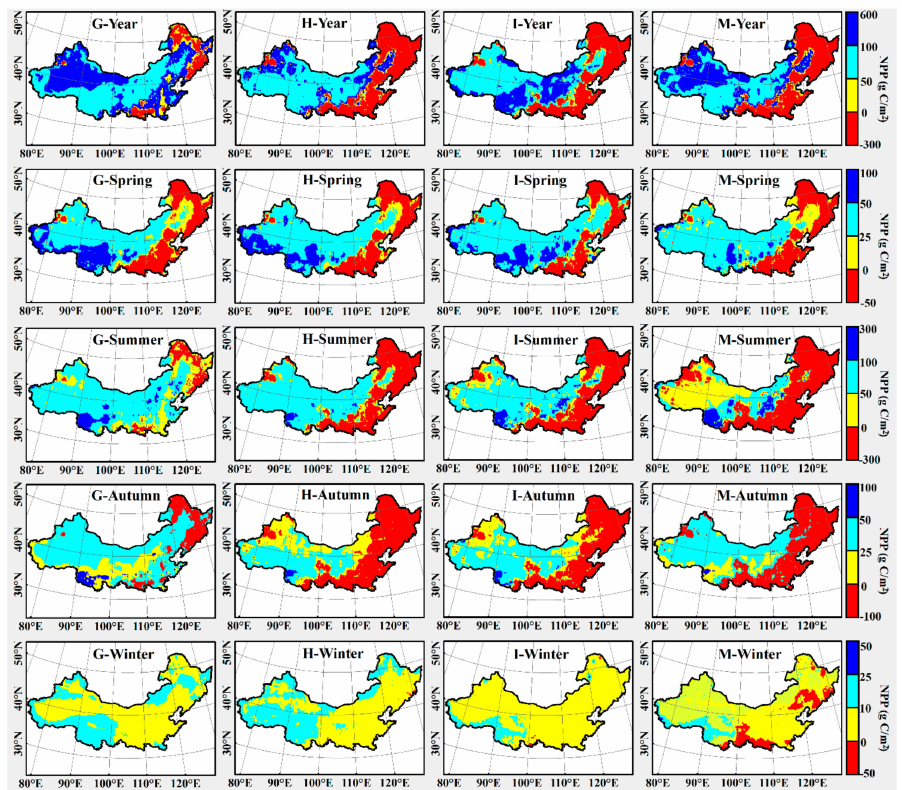
Figure 6. Spatial distribution of the changes in NPP under GW_2.0 ◦ C for annual and seasonal projections. Notation used for climate models and definition of seasons—as in caption to Figure